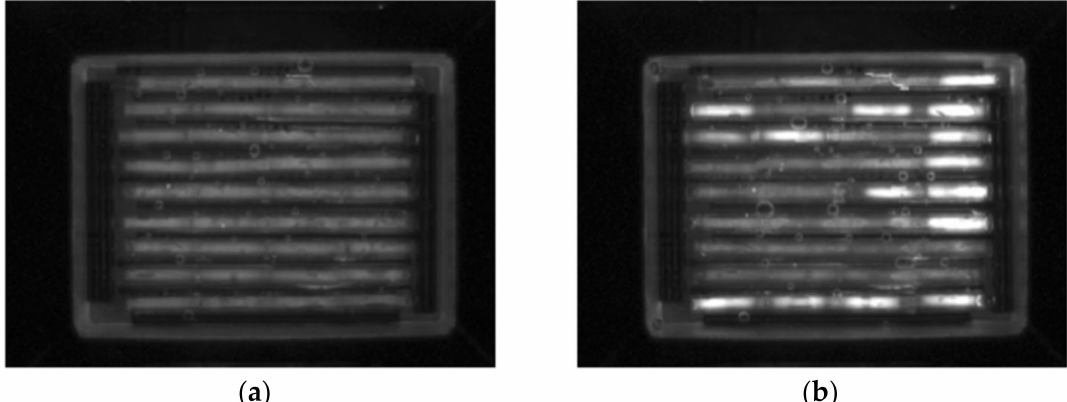
Figure 2. CCD images of a cassette with 36 capillaries in 9 trenches with 4 capillary reaction units per trench that detects 7 swab samples in the first 7 trenches. ( a ) at 1st PCR cycle and ( b ) at 35th cycle. Four capillaries in each trench from left to right have O157, eae , stx1 and stx2 primers. The last trench (9th) has the positive control and 8th trench has the negative control. These images were first published in Manage et al.